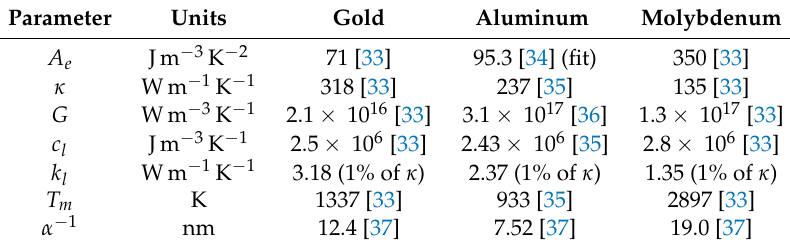
Table 1. Parameters used in the stability analysis. T m denotes the melting